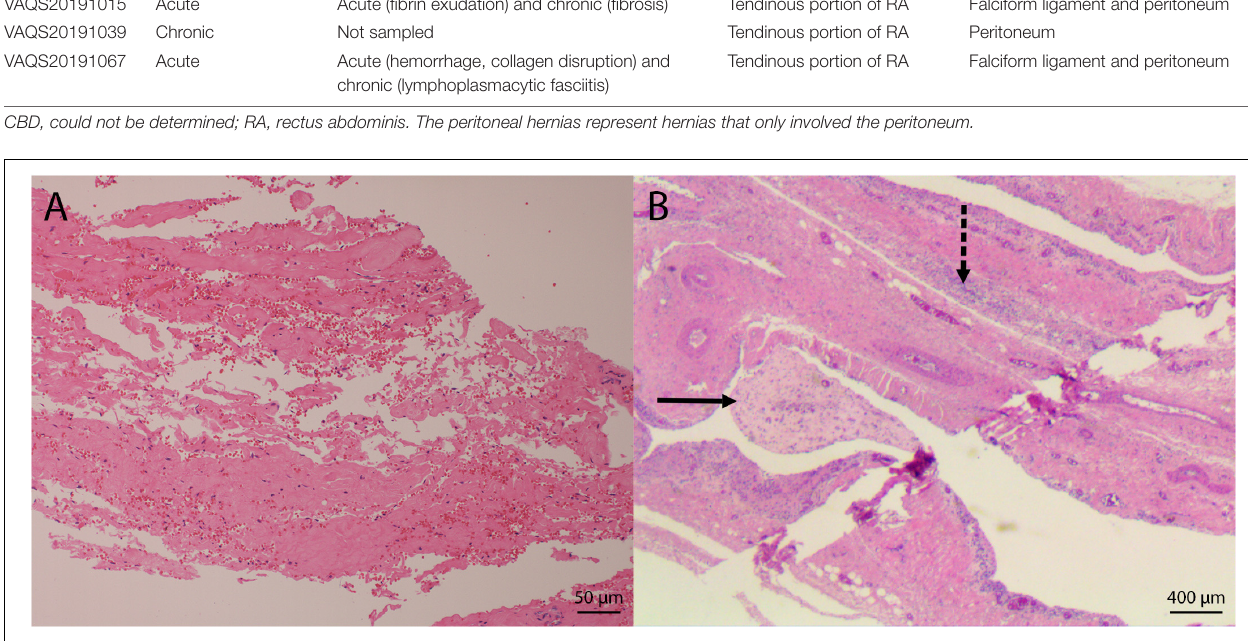
FIGURE 4 | Microphotographs of hernias in bottlenose dolphins. (A) Disruption of collagen bundles with associated hemorrhage in an acute hernia. (B) Fibrovascular fronds extend from the site of the chronic hernia (solid arrow). Inflammatory cells infiltrate the wall (dashed